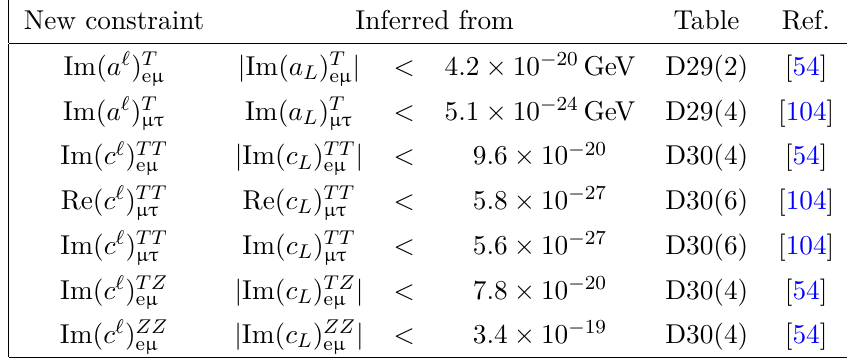
Table 4 . Coefficients on which new constraints can be inferred (first column), coefficients in the neutrino sector from which the constraints were inferred (second column) along with the particular tables of ref. [22] that the values were taken from (third column), and the original references (fourth column). Only the bounds that are not stated in the summary tables of ref. [22] are given. Pure laboratory experiments were prioritised over experiments involving cosmic